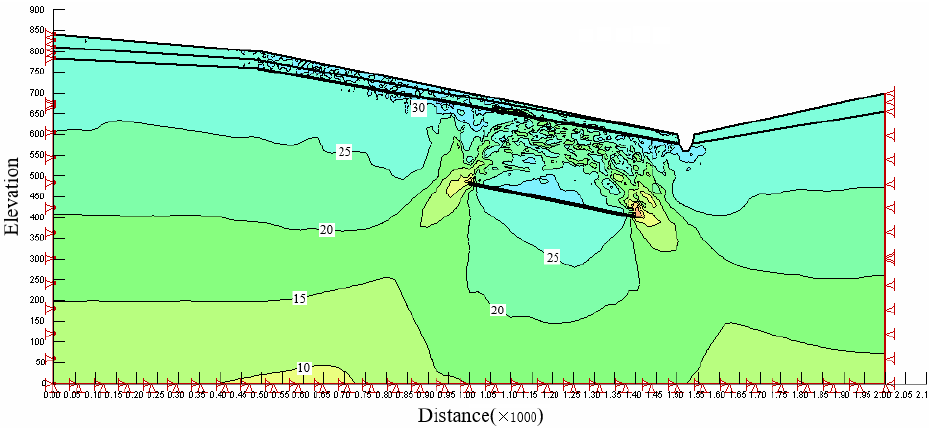
Figure 13. The contour map of major principal stress after mining.